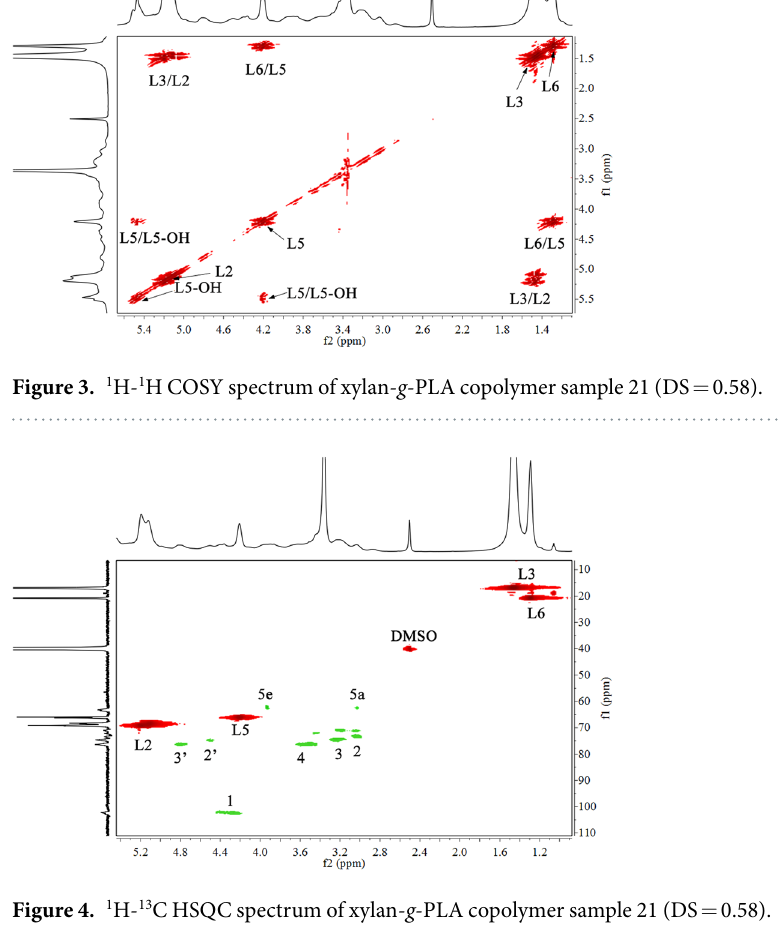
Figure 4. 1 H- 13 C HSQC spectrum of xylan- g -PLA copolymer sample 21 (DS =